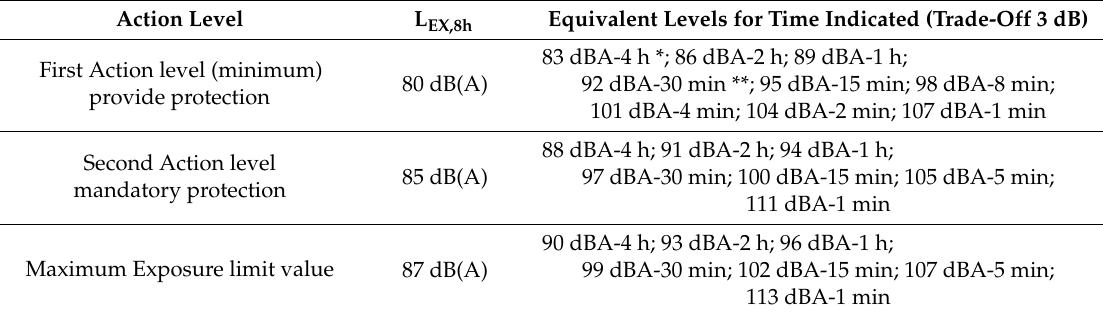
Table 1. The examples of equivalent time-intensity levels referred to action levels according to Directive 2003/10/EC